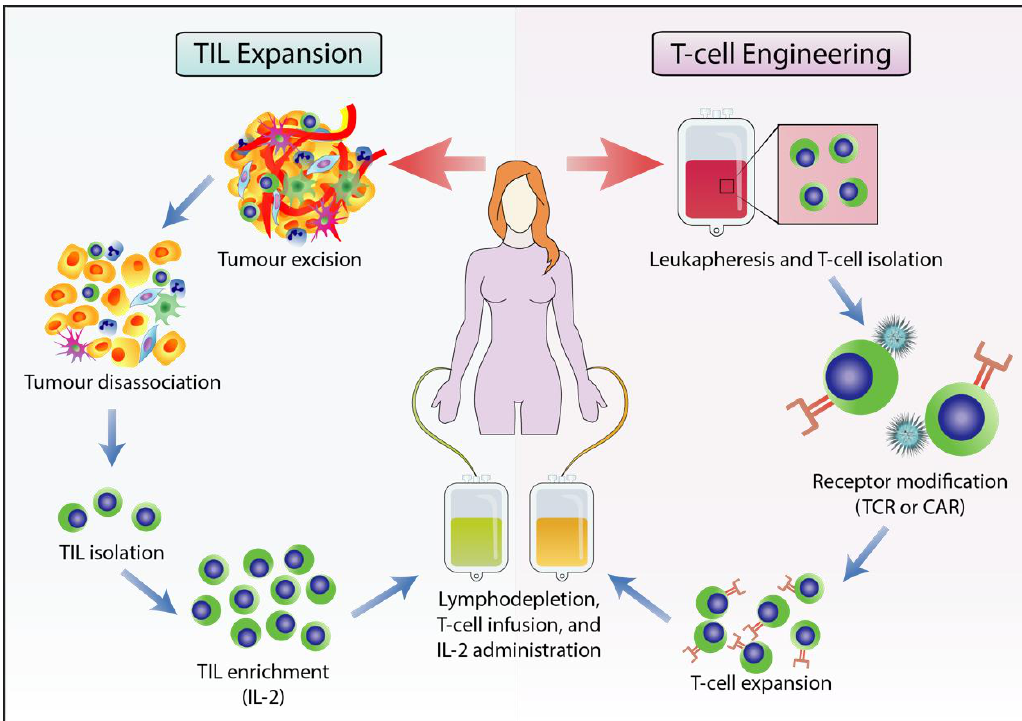
Figure 1. Workflow of adoptive T-cell therapy using TILs or receptor modified T-cells. Adoptive T-cell therapy can improve anti-tumour response by expanding TIL populations extracted from patient tumour (left), or genetically modifying the TCR or generating a chimeric antigen receptor (CAR) (right). With TIL expansion, the patient tumour is surgically resected and the TILs are isolated and expanded ex vivo. The TIL populations are then further increased through a Rapid Expansion Protocol before they are intravenously infused back into the lymphodepleted patient. For the genetic modification of T-cell, the TCR and CAR-T therapy extracts T-cells from the peripheral blood via leukapheresis and are transduced with viral vectors to express a modified TCR or CAR. In both approaches, the patient is lymphodepleted with cyclophosphamide before T-cell infusion and is administered with IL-2 to improve treatment efficacy and longevity.